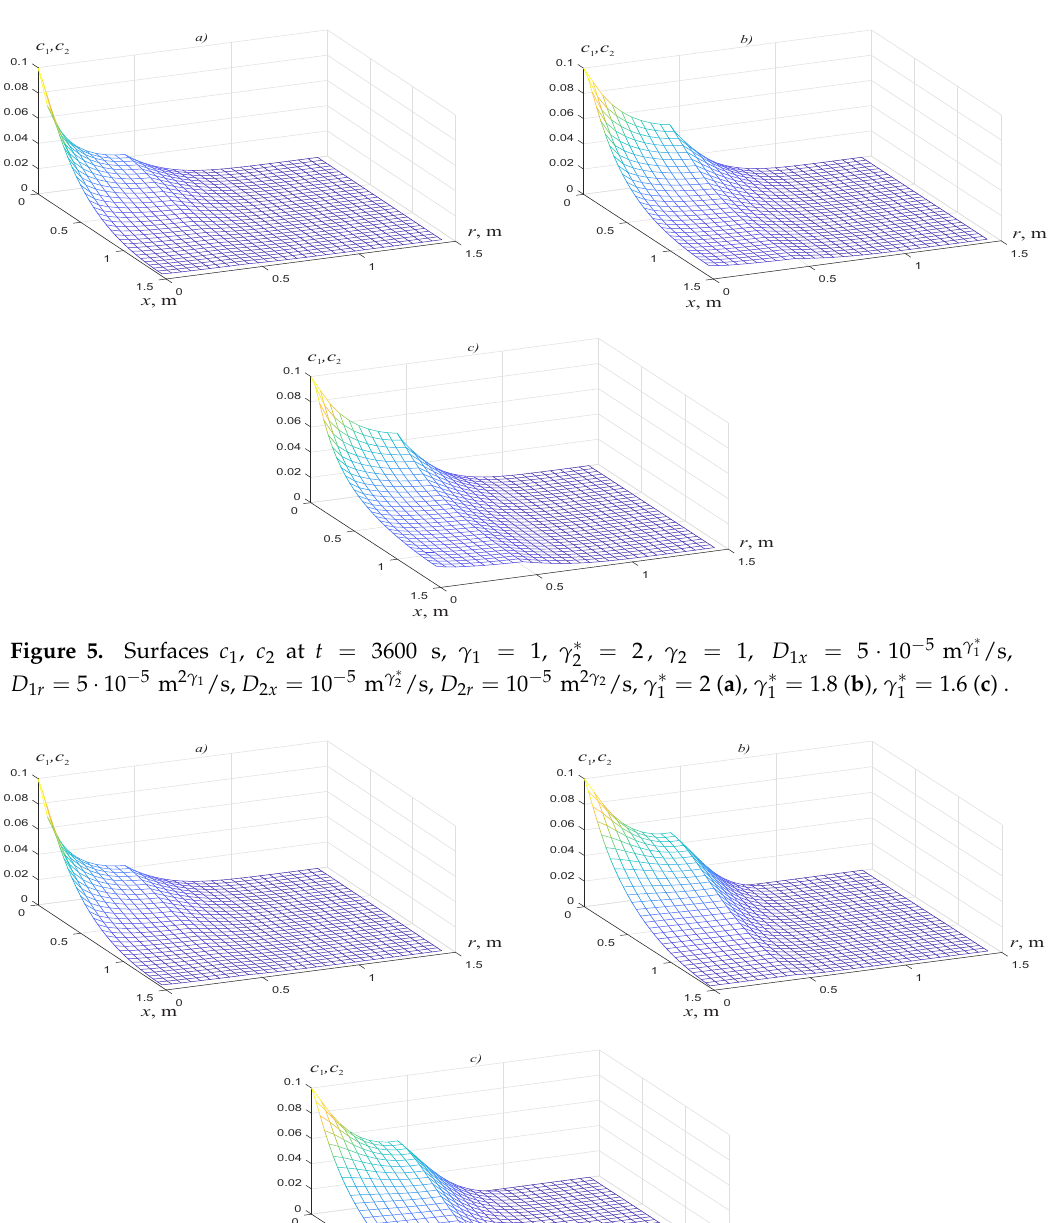
Figure 6. Surfaces c 1 , c 2 at t = 3600 s, γ 1 = 1, γ ∗ D 1 r = 5 · 10 − 5 m 2 γ 1 /s, D 2 x = 10 − 5 m γ ∗ 2 /s, D 2 r = 10 − 5 m 2 γ 2 /s, γ ∗